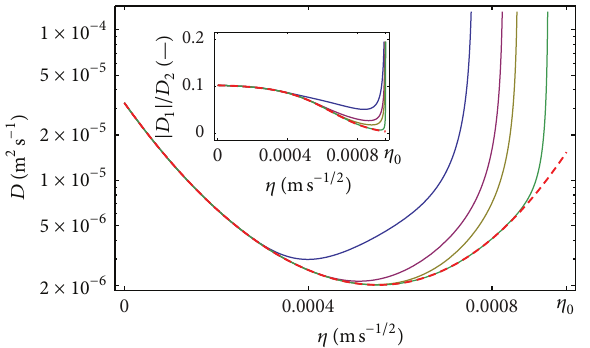
Figure 4: The dependence of the chloride diffusion coefficient on the Boltzmann variable. The full lines correspond to formula (23), using 𝜂 𝜏 = 𝜂 0 ,1.5𝜂 0 ,2𝜂 0 , 5𝜂 0 (from left to right). The inset shows that the relative contribution of 𝐷 1 to 𝐷 is quite small, not exceeding 10 %. The dashed line indicates the case with an immediate binding of salt ( 𝜂 𝜏 → ∞ ).